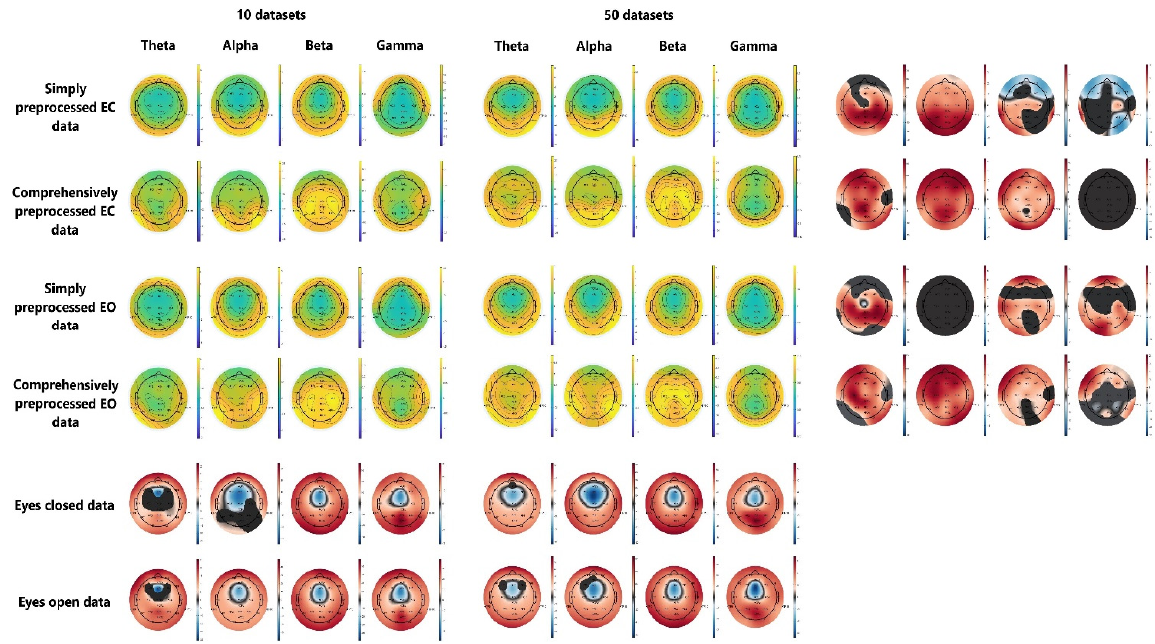
Figure 5. The comparison of frequency band powers by dataset size and data cleaning procedure. The data is organized to represent different frequencies by column (theta— Θ , alpha— α , beta— β , gamma— ɣ ) and data cleaning and preprocessing procedure in rows (comprehensively and simply preprocessed data). The frequency powers are depicted in green and yellow colors, while the red- blue-and-black headplots depict t -values of permutation t -tests, comparing either simply and com- prehensively preprocessed data (bottom) or the data derived from the first 10 with the data derived from the whole 50 subject dataset (right). The black patches on the red-blue-and-black headplots mark the areas where no significant differences were detected.